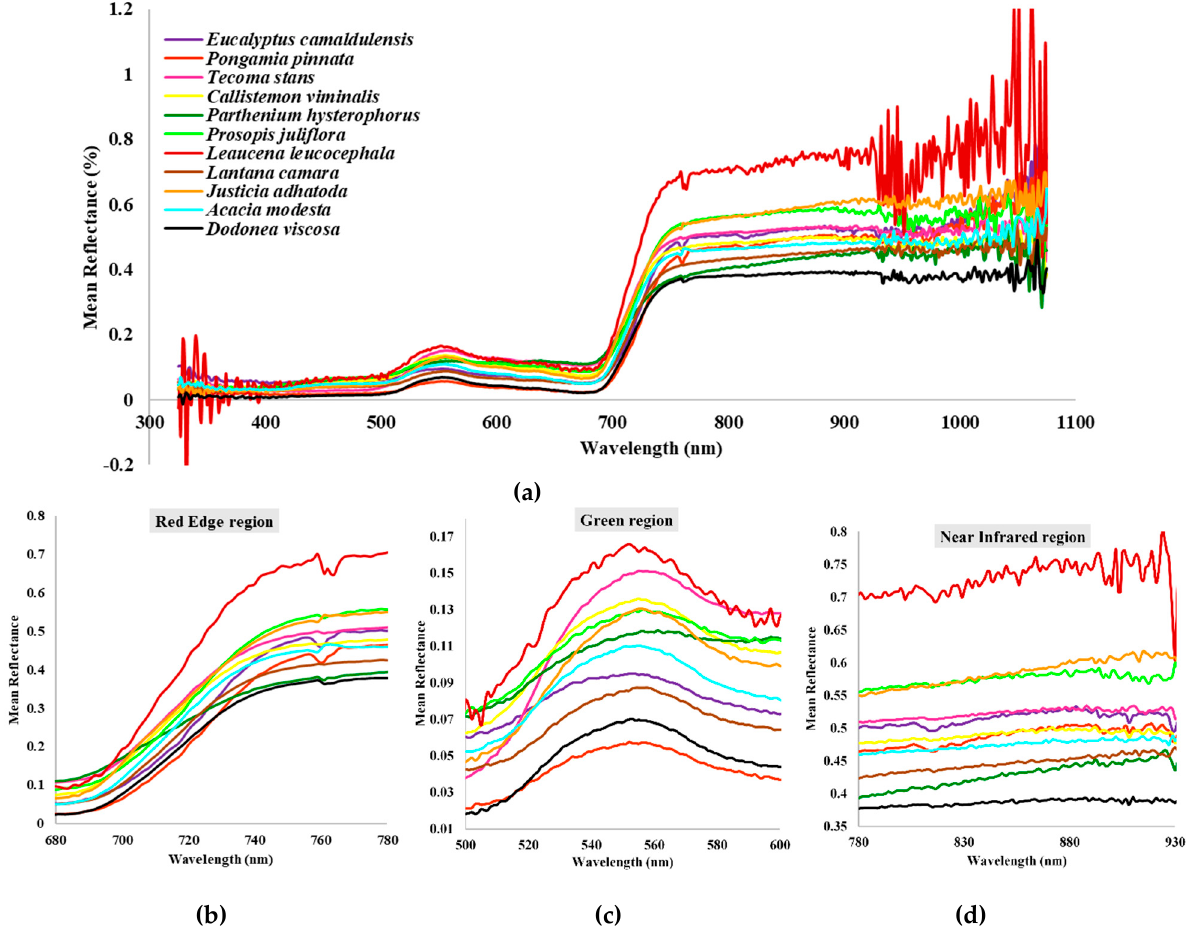
Figure 7. Spectral signatures of all plant species showing mean reflectance ( a ), green ( b ), red-edge ( c ) and NIR region ( d ). Table 4. Frequency of significant wavebands in different regions of electromagnetic spectrum based on ANOVA ( p < 0.05). Wavelength